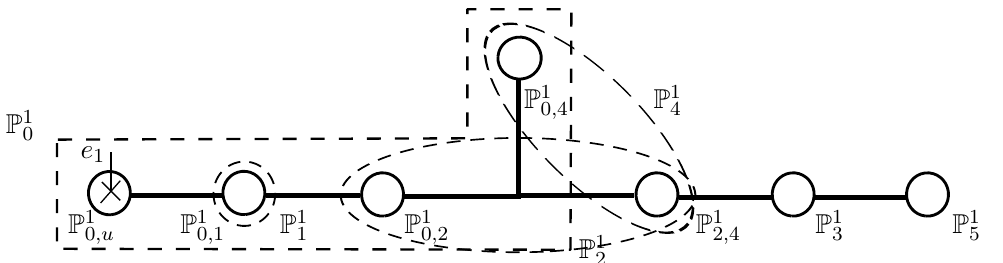
Figure 10 . P 1 intersection pattern at z 16 10 coupling 16 (cid:0) 3 = 2 . 3 = 4 3 = 4